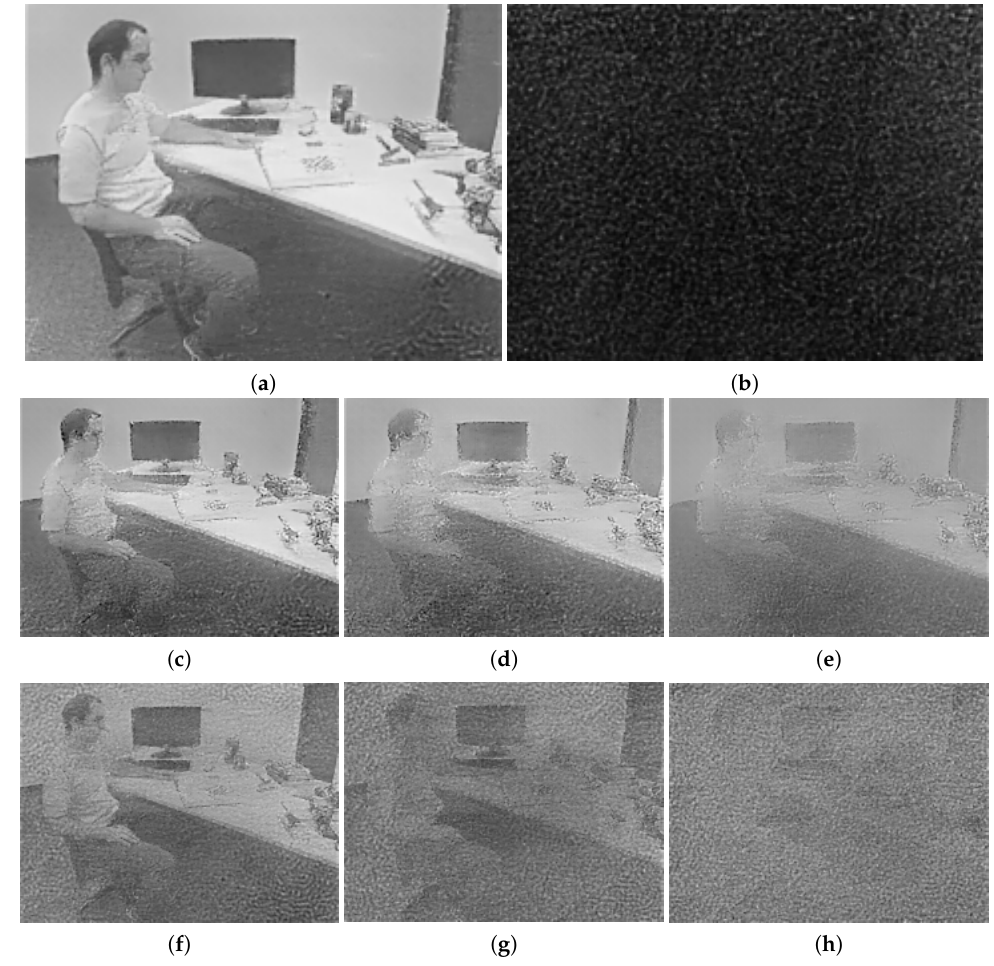
Figure 6. The reconstructed grayscale images of the same event stream under different conditions. ( a ) Image reconstructed from the original event stream. ( b ) Image reconstructed from encrypted events using our proposed framework. ( c – e ) Images reconstructed from 50%, 67%, and 75% encrypted events using the partial discarding algorithm, respectively. ( f – h ) Images reconstructed from 50%, 67%, and 75% encrypted events using the partial scrambling algorithm,